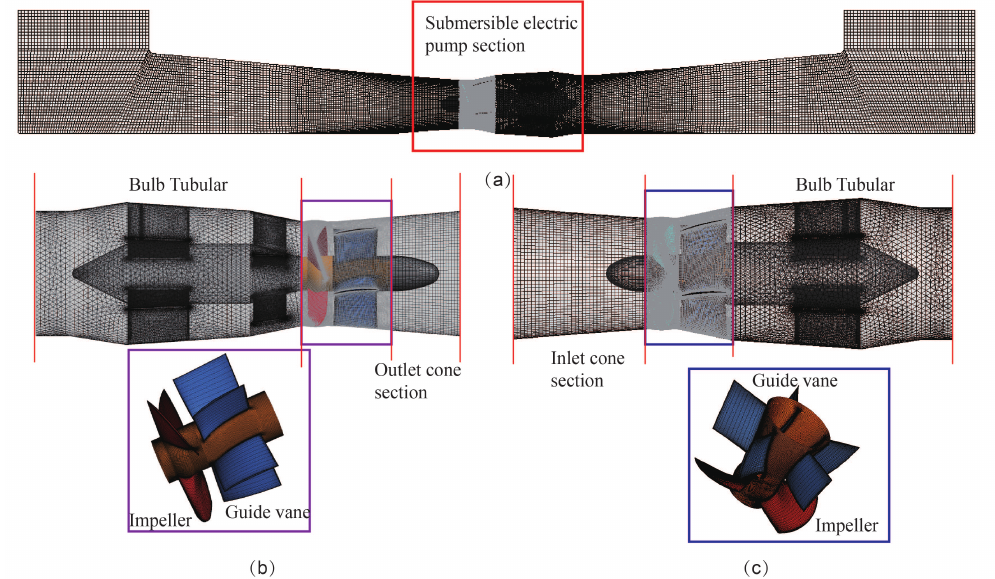
Figure 2. Grid diagram of submersible tubular pump installation: ( a ) Pump unit; ( b ) front-mounted scheme; ( c ) rear-mounted